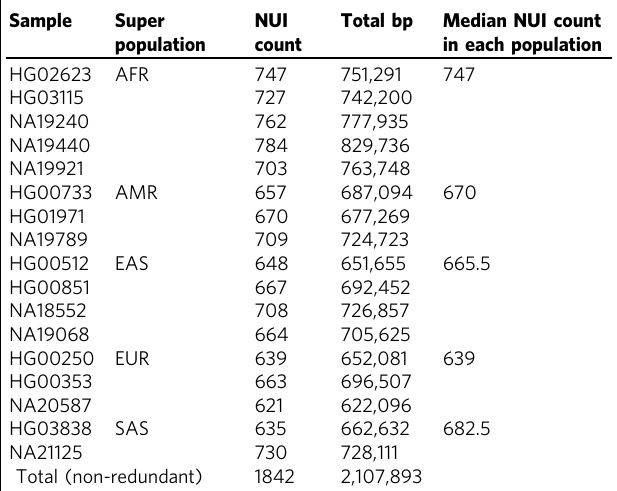
Table 1 Non-reference unique insertions summary